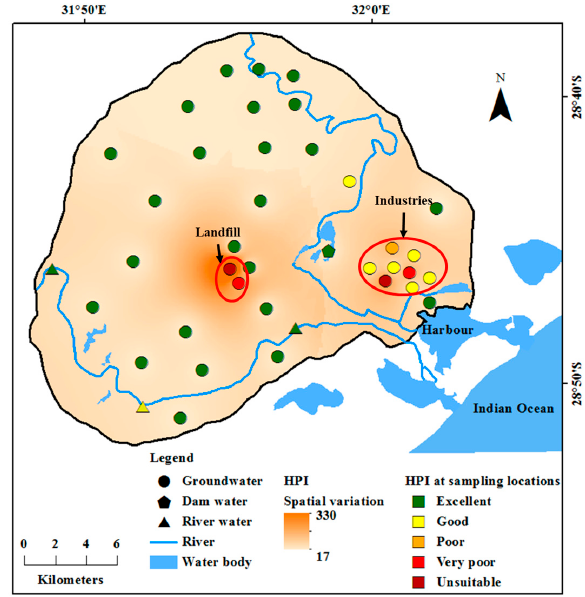
Figure 4. Spatial variation in HPI of water. Table 4. Human exposure risk (mg/kg/day) due to heavy metals through the drinking water pathway. HeavyMetalinGroundwater( N HumanExposure Statistical Category Parameter